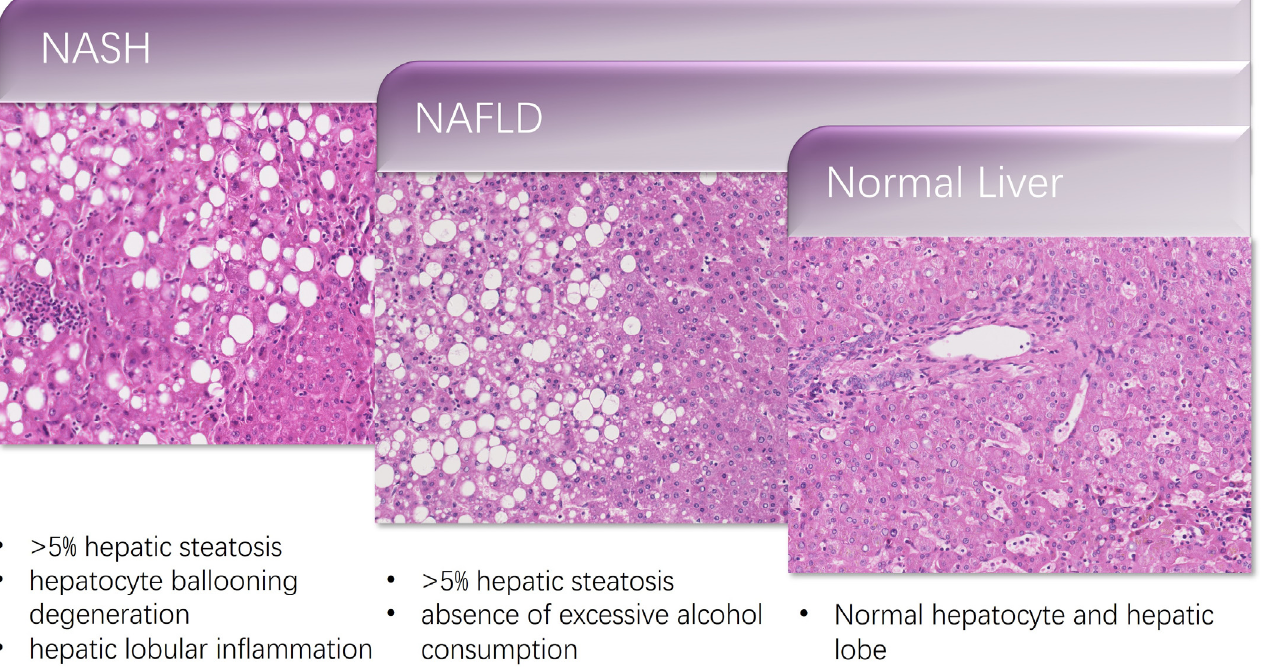
Figure 1. Histologic features of nonalcoholic steatohepatitis. NASH can be diagnosed without invasion by means of imaging, serum biomarkers, and biomarker panels. Common serum biomarkers include cytokeratin-18 (CK18) [20], inflammatory markers (CXCL10, TNF- α , IL-8) [21–23], adipocytokines and hormones (FGF21) [20], serum iron [24], etc. Biomarker panels include NASH Test [25], NASH ClinLipMet score [26], etc. Diagnostic imaging tools include vibration-controlled transient elastography (VCTE) [24], magnetic resonance elastography (MRE) [27], MRI-based technology assessing liver iron accumulation [24], multiparametric magnetic resonance imaging (MRI) technology [28], etc. Some of the above techniques demonstrate good sensitivity and specificity in small samples. In addition, some microRNAs, such as miR-34a and MiR-122 [28,29], also have the potential to be effective